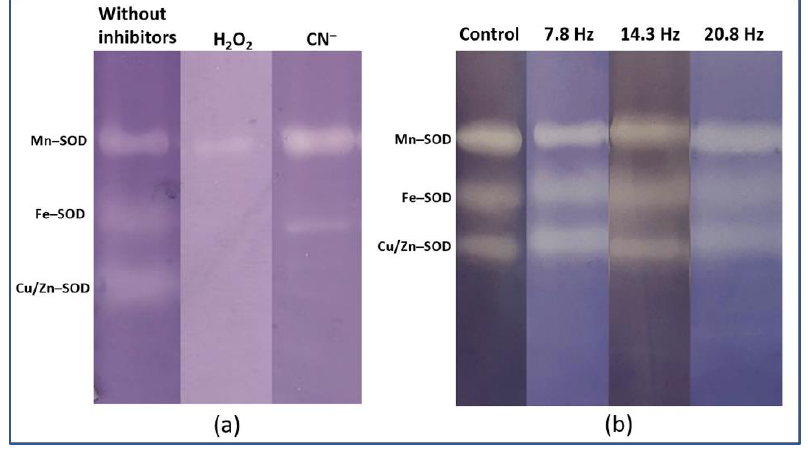
Figure 4. Isoenzyme activity patterns of SOD from pea leaves: ( a ) inhibitory analysis of SOD; ( b ) typical pattern of the activity of SOD isoforms after exposure to ELF EMF of different frequencies.